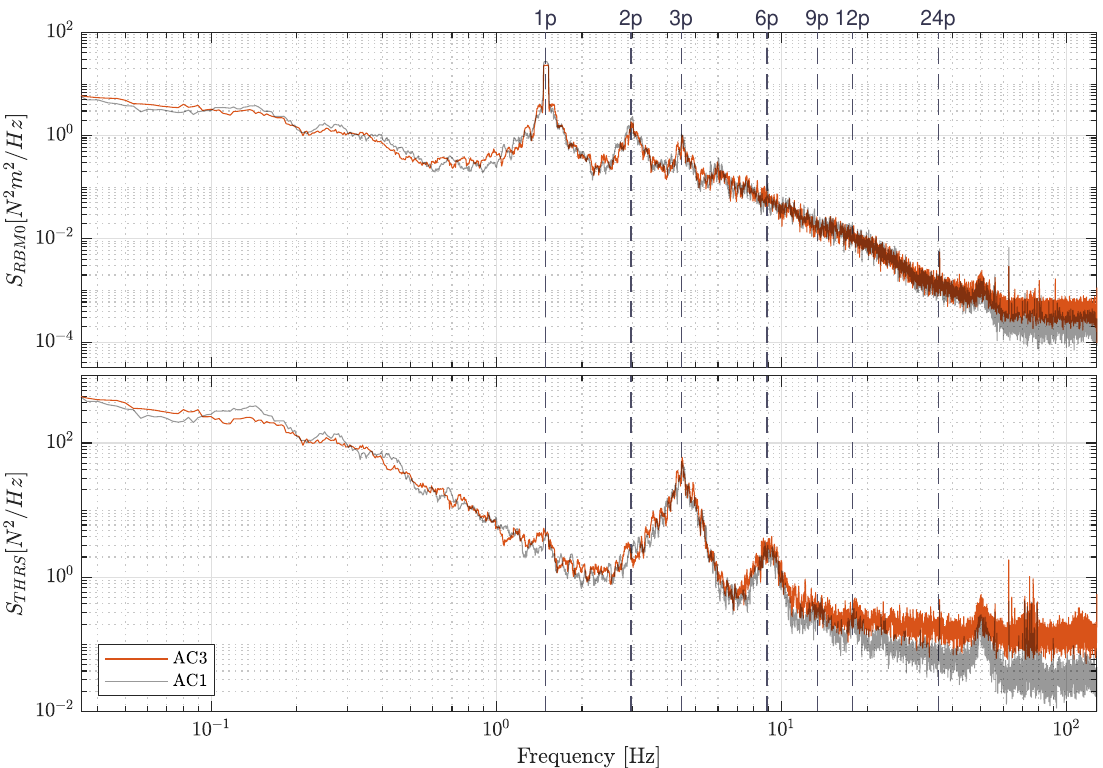
Figure 10. Spectral density plots of the thrust and the blade root bending moment experienced by the primary turbine, with the front two turbines (AC3) and from the single turbine case (AC1). All turbines operating at 90